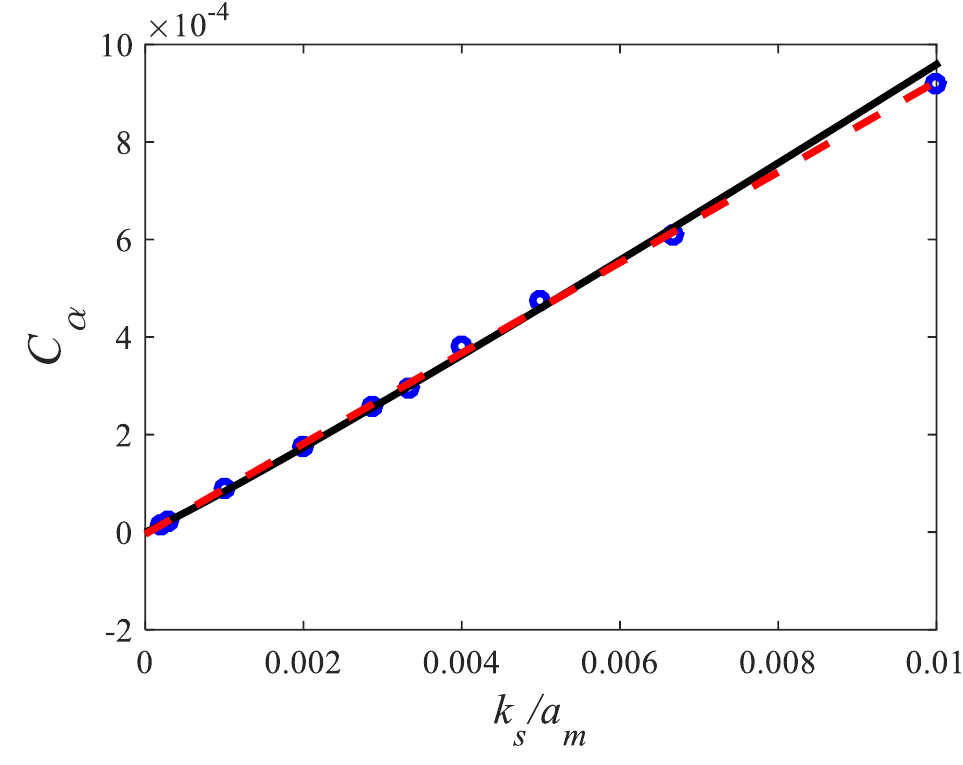
Figure 10. Parameter C α as a function of k s / a m , black solid line: Equation (12); red dashed line: Equation (13), symbols: data from the BSL k- ω model.